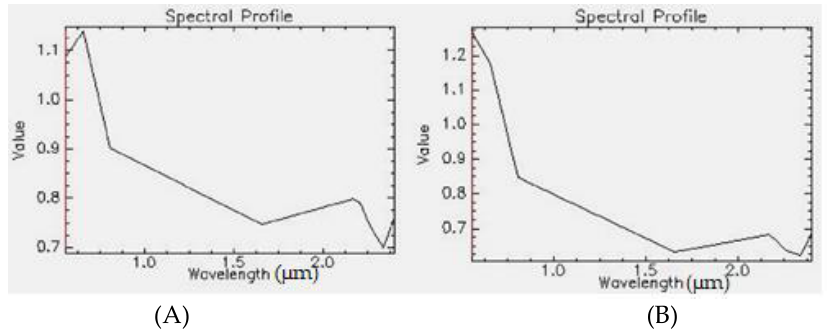
Figure 8. Spectral plots of two types of serpentinization intensity: ( A ) high serpentinization; ( B ) low serpentinization.